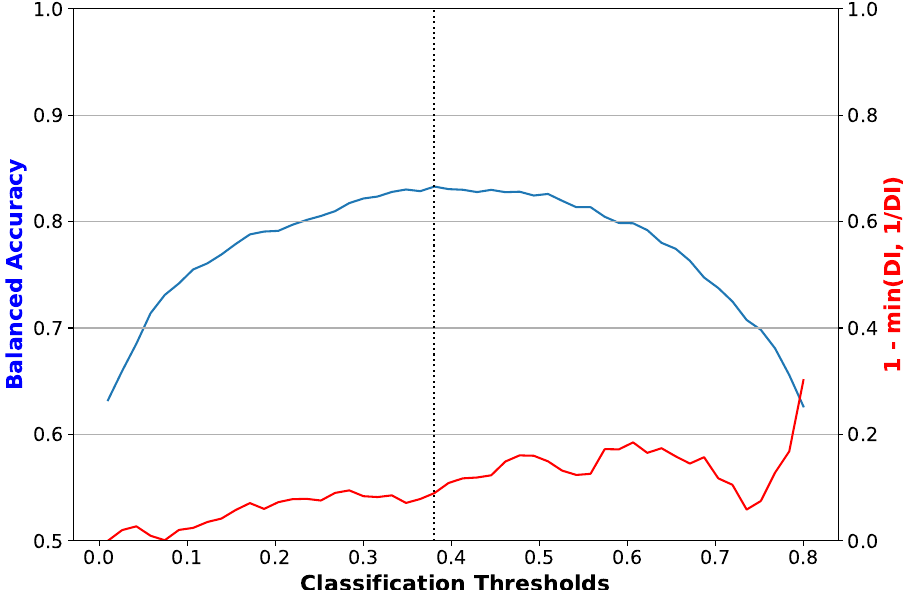
Figure 4. Balanced accuracy and disparate impact error versus classification threshold for a logistic regression classifier with reweighing. The dotted vertical line is the threshold that maximizes balanced accuracy. The plot shown corresponds to one of the folds of cross-validation. Disparate impact error, equal to 1- min (DI, 1/DI), where DI is the disparate impact, and the difference between disparate impact and its ideal value of 1.